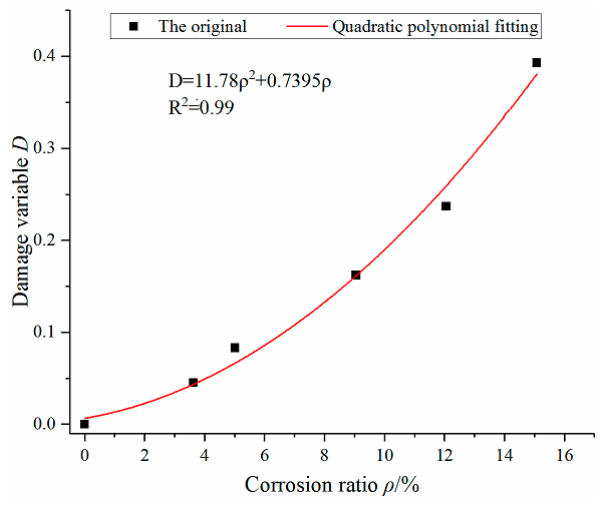
Figure 11. The relationship curve of damage variable D and corrosion ratio ρ .